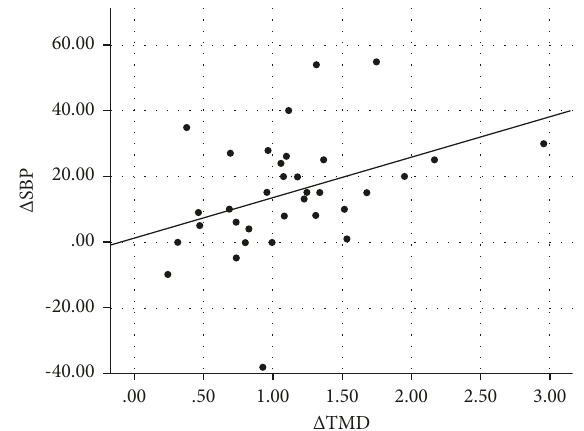
Figure 5: Scatter plot graph of